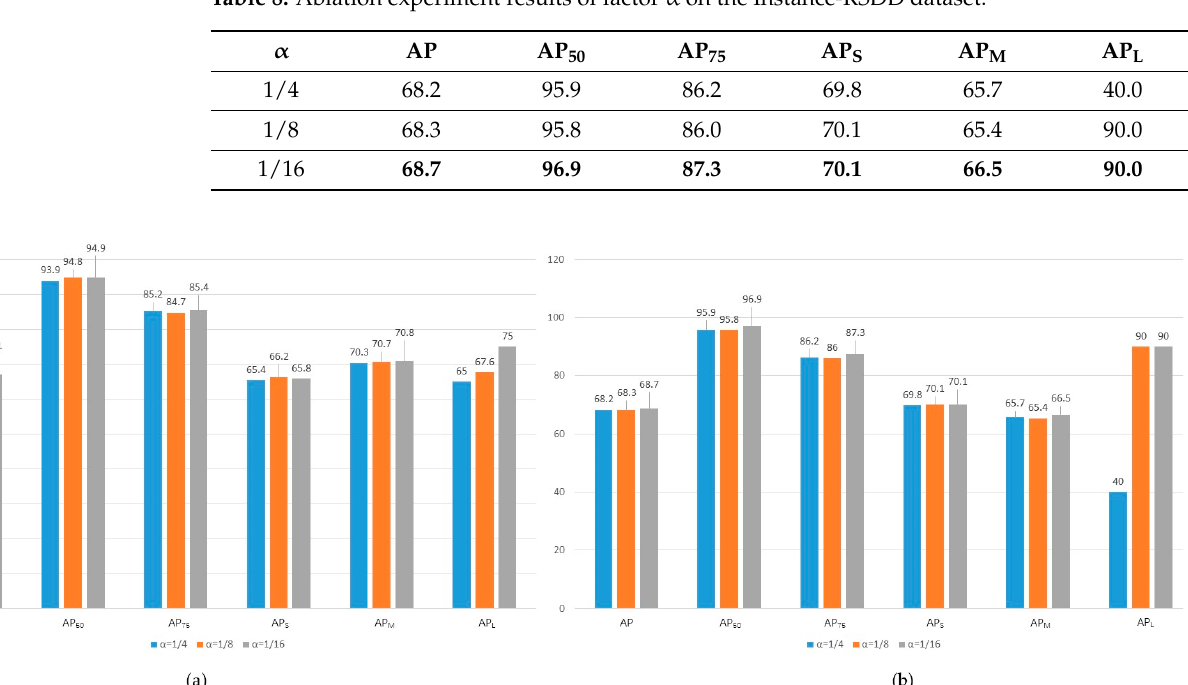
Figure 17. Histograms of the ablation experimental results of factor α on the SSDD ( a ) and the Instance-RSDD dataset ( b ).